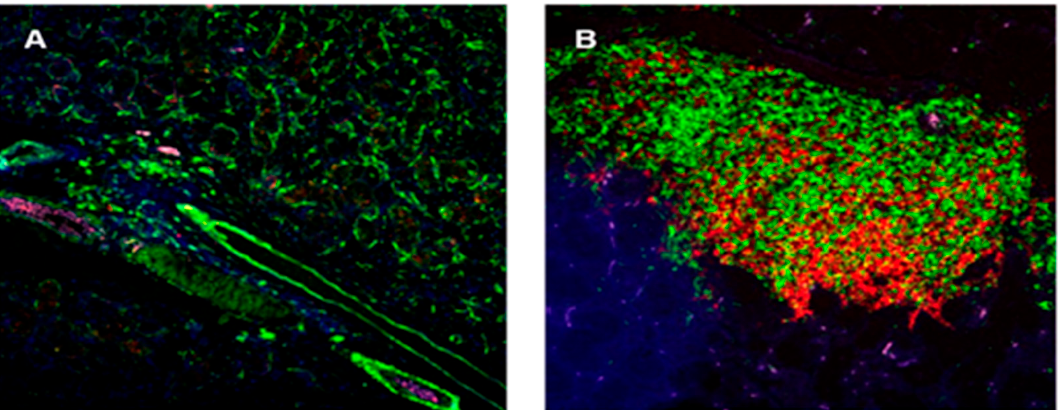
Figure 1. Histological photomicrographs depicting lymphocytic infiltrations present within the salivary glands of C57BL/6.NOD- Aec1Aec2 mice at 16 ( A ) and 31 ( B ) weeks of age. Infiltrations are age-dependent and contain an ever- changing proportion of both T cells (green fluorescence) and B cells (red fluorescence). Lymphocytic infiltration, especially in SS-susceptible C57BL/6.NOD- Aec1Aec2 mice, is strongly periductal. Visualization is at 200X magnification.